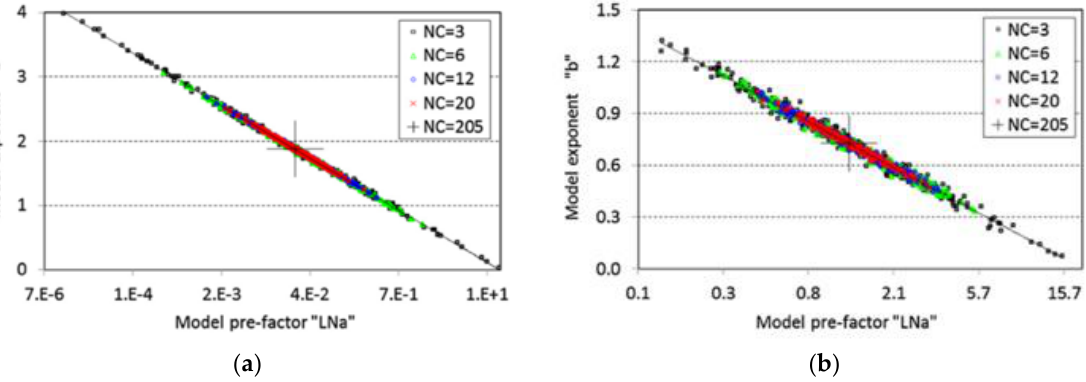
Figure 5. Trade-off between model parameters (for 300 iterations) with single methods for different numbers of NC [40]. ( a ) R test results, power model, b = f(LNa), ( b ) V test results, exponential model, b =